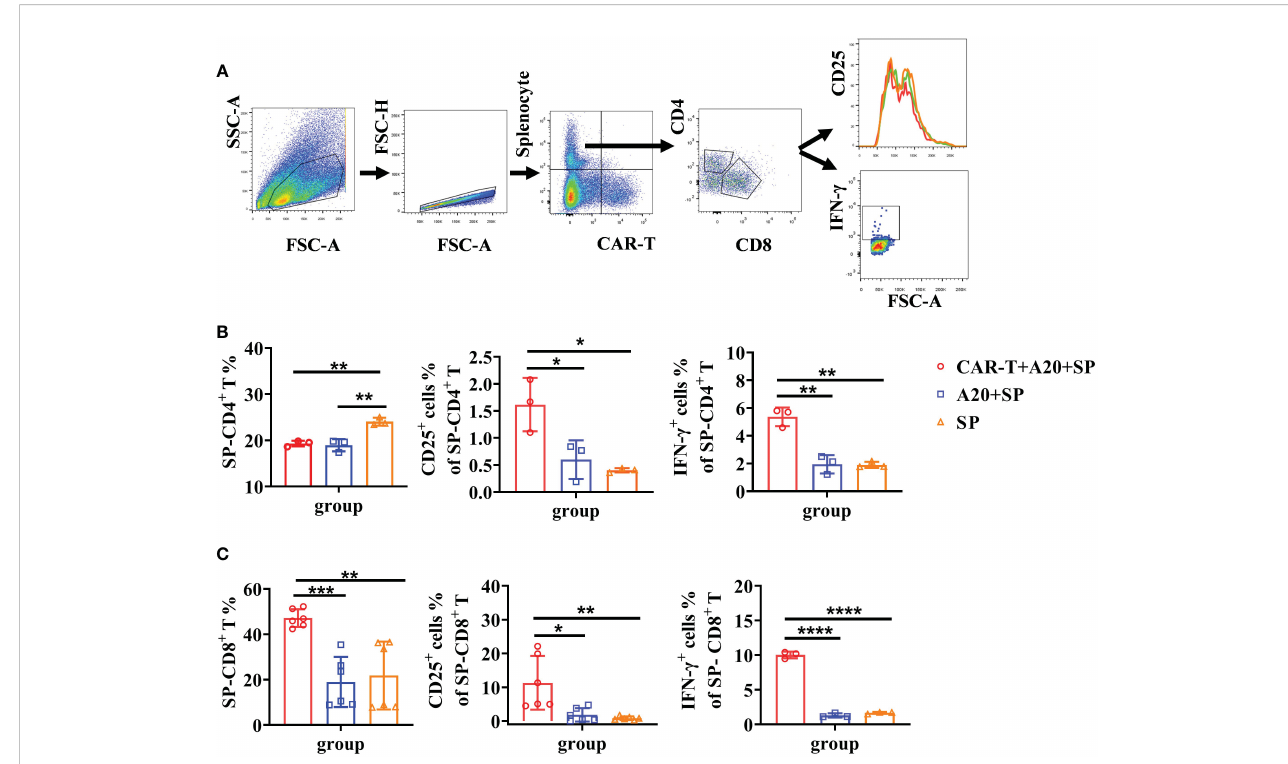
FIGURE 5 Elevated syngeneic T cell responses were induced by CD19 CAR-T triggered tumor lysis. Splenocytes from BALB/c mice were harvested and stained with Cell Trace Far Red. Syngeneic splenocytes, CD19 CAR-T, and A20 cells were co-cultured in vitro . Flow cytometry was done to detect T-cell activation and cytokine secretion. (A) Gating strategy of fl ow cytometry. (B, C) The percentage of T cells and the expression of IFN- g . * P < 0.05, ** P < 0.01, *** P < 0.001, **** P <